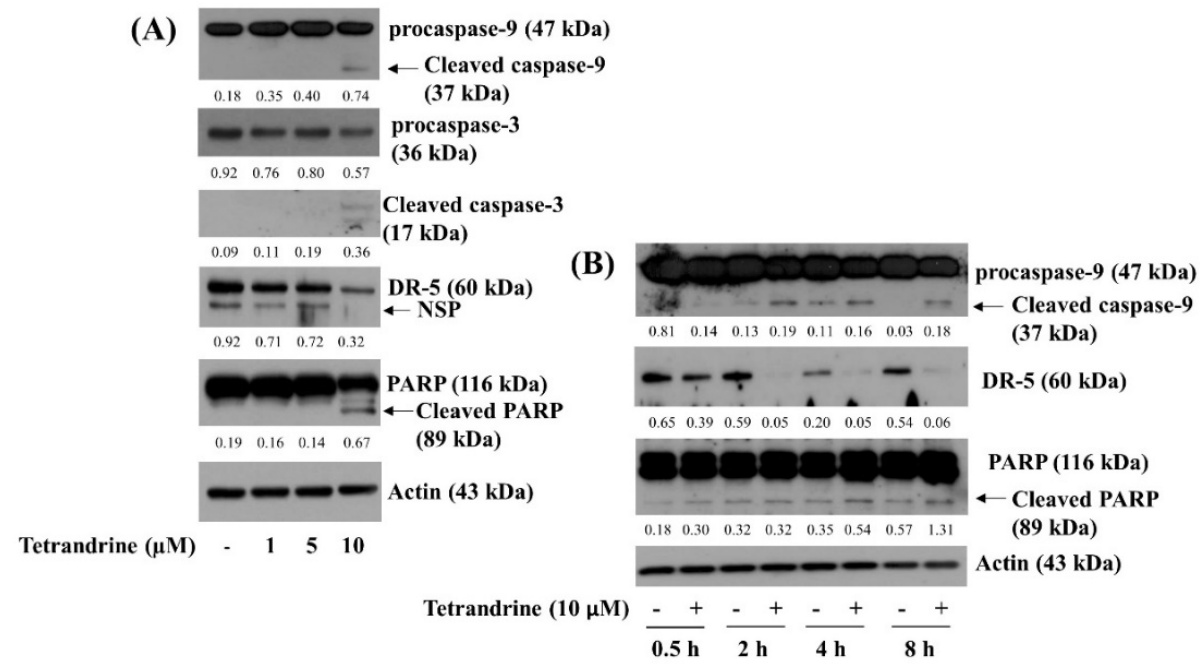
Figure 2. Effects of tetrandrine on the expression of caspases, DR-5, and PARP in SW872 cells. ( A ) SW872 cells were treated with vehicle control (0.1% DMSO) or tetrandrine at different concentra- tions (1, 5, or 10 μ M) for 24 h. Whole-cell lysates from the conditioned cells were prepared and analyzed by Western blotting to measure the expression of procaspase-9, procaspase-3, DR-5, PARP, or β -actin. ( B ) SW872 cells were treated with vehicle control (0.1% DMSO) or tetrandrine at 10 μ M for the designated time point. Whole-cell lysates from the conditioned cells were prepared and an- alyzed by Western blotting to measure the expression of procaspase-9, procaspase-3, DR-5, PARP, or β -actin.